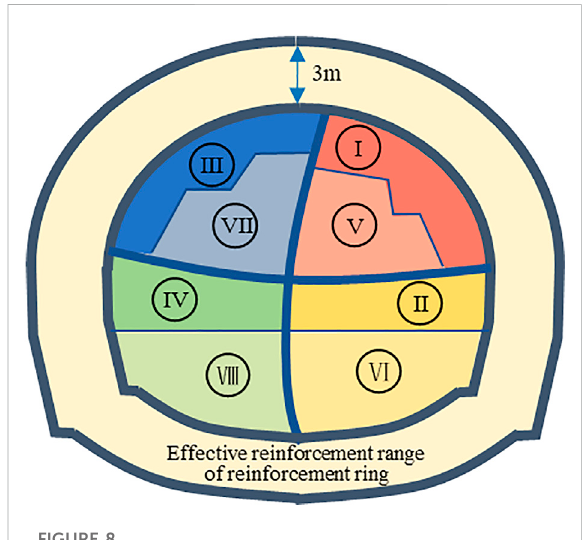
FIGURE 8 Schematic diagram of the new excavation process.